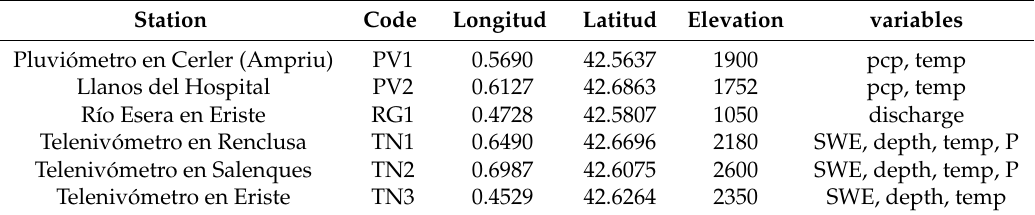
Table 1. Coordinates of the measuring stations indicated in Figure 1. SWE is snow water equivalent, pcp is precipitation, temp is temperature and P is atmospheric pressure. Station Code